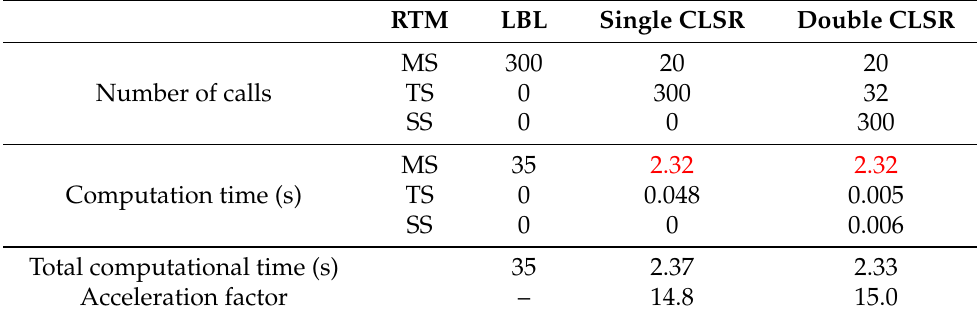
Table 2. Summary of number of calls, computational time and acceleration factors for the Hartley– Huggins band. The computational times marked in red indicate the computational